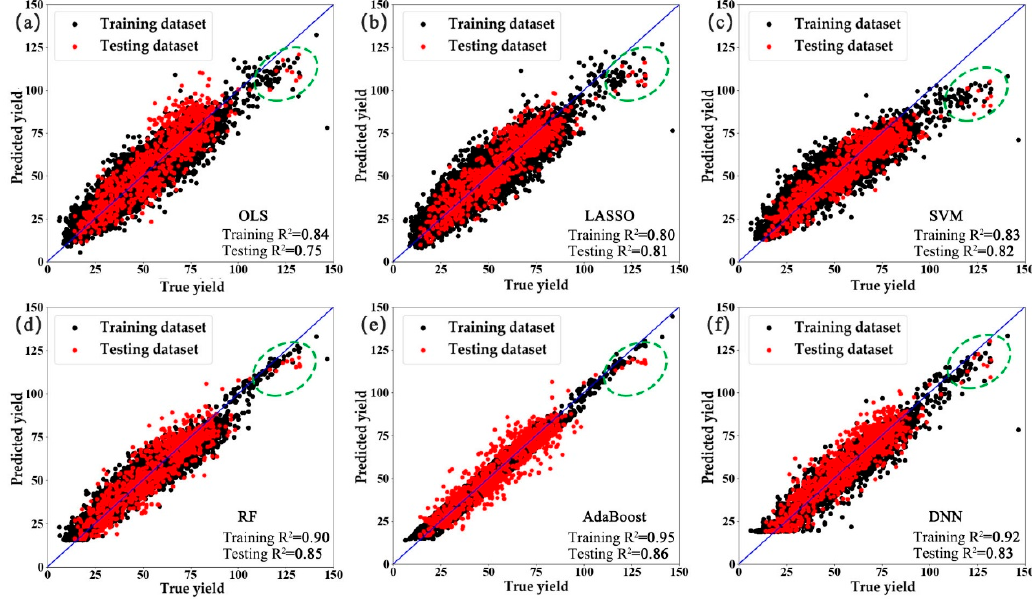
Figure 3. The scatter plots of the six models using the selected factors (the green ellipses represent the underestimated regions): ( a ) OLS; ( b ) LASSO; ( c ): SVM; (d): RF; ( e ): AdaBoost; ( f ): DNN.